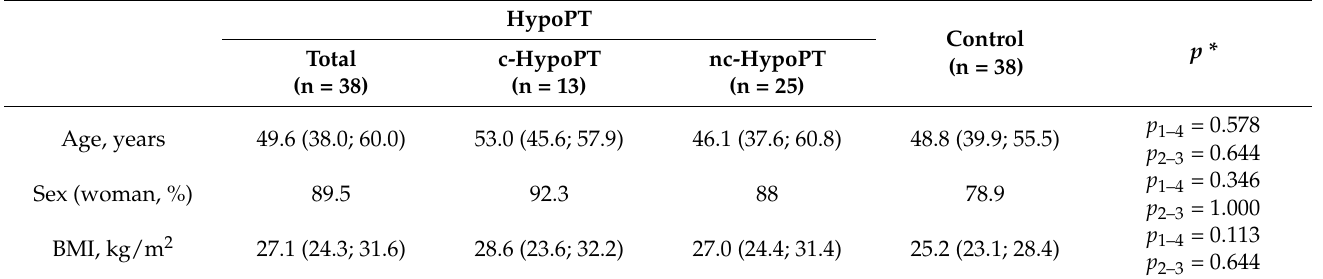
Table 1. General characteristics of the